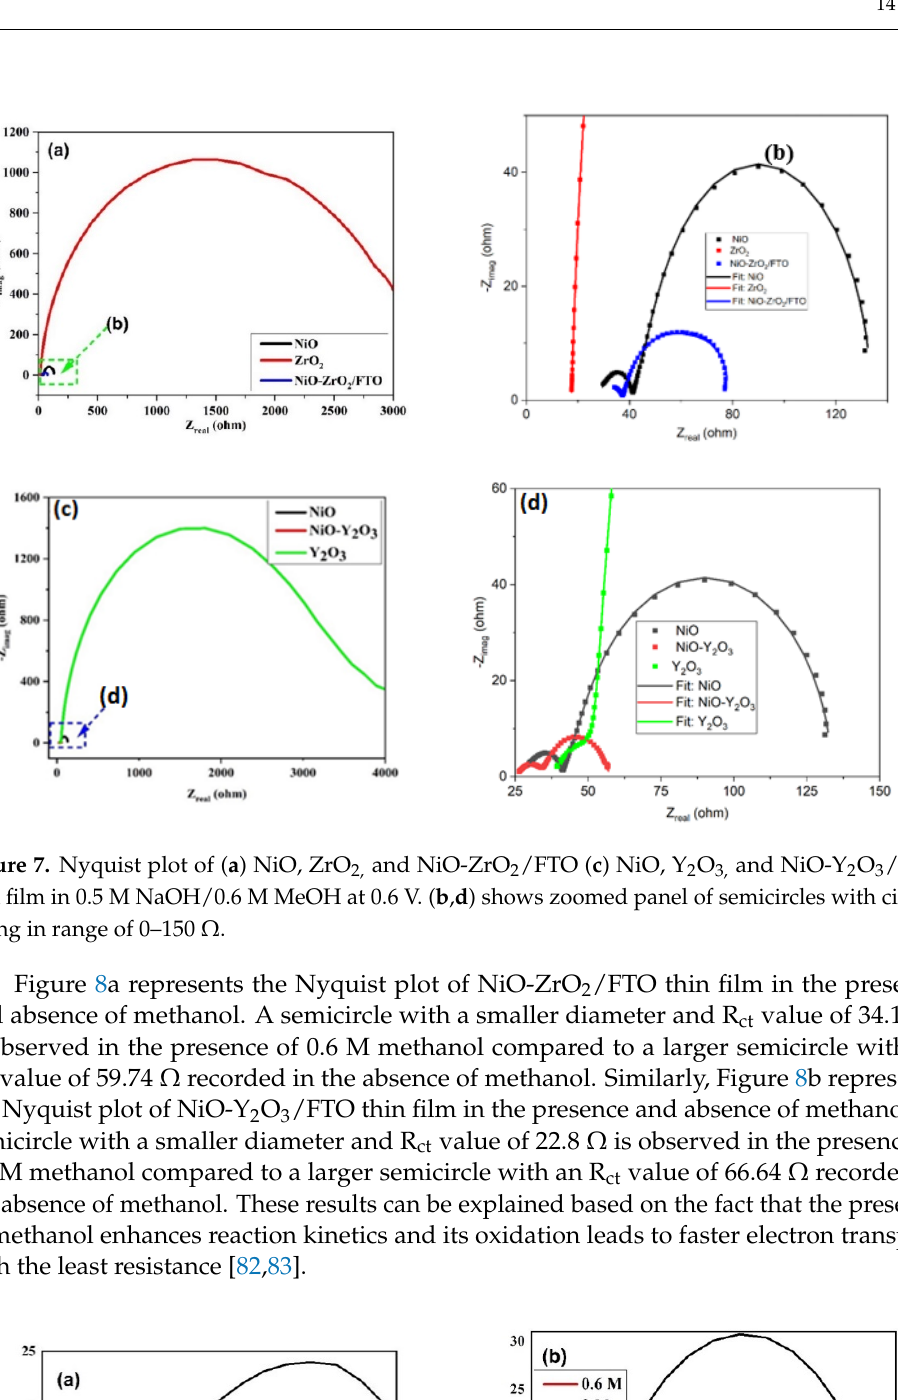
Figure 8. Nyquist plot of ( a ) NiO-ZrO 2 /FTO and ( b ) NiO-Y 2 O 3 /FTO thin film in the absence and presence of 0.6 M methanol.